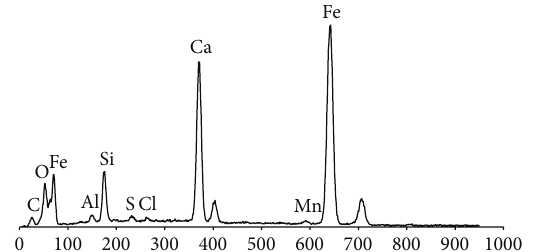
Figure 7: EDX analysis showing elements in the interphase and their proportions based on peak size. Table 2: Amount of elements (% of weight) as determined by SEM- EDX.